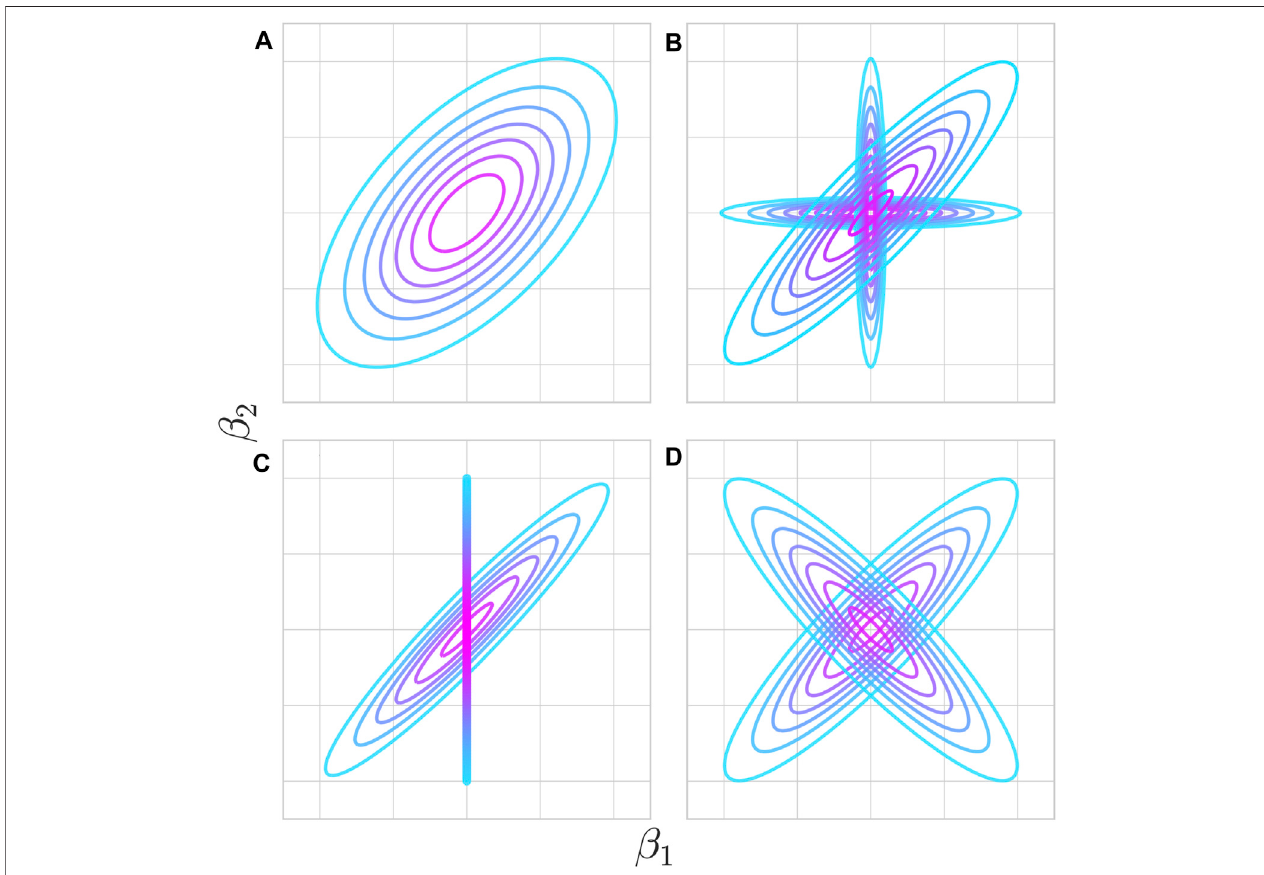
FIGURE3| Variouspotentialpleiotropicrelationshipsatindividuallociunderliegeneticcorrelationsbetweentraits. (A) Mutationsaffectingtrait1haveatendencyto impact trait 2 in a particular direction, although a variety of outcomes are possible through the functional particulars of that change. (B) Mutations fall either into a shared orunsharedfunctionalpathwaybetweenthetwotraits.ColocalizationanalysisaimstotestwhichdistributionagivenQTLcomesfrom.Eventhoughnoteverymutationis pleiotropic,thetwotraitsaregeneticallycorrelated.Theproportionofmutationsfallingintoeitherpathwaydeterminesthestrength ofgeneticcorrelation. (C) Trait1 has a causal impact on trait 2 such that every mutation with a non-zero effect on trait one has a strongly correlated effect on trait 2, but not vice-versa. Mendelian randomization aims totest for theexistence and direction ofthis effect. This also manifests asa genetic correlationat the phenotypic level. (D) Individual variants may be pleiotropic, but can result in low or zero genetic correlation if different pathways have opposing effects.